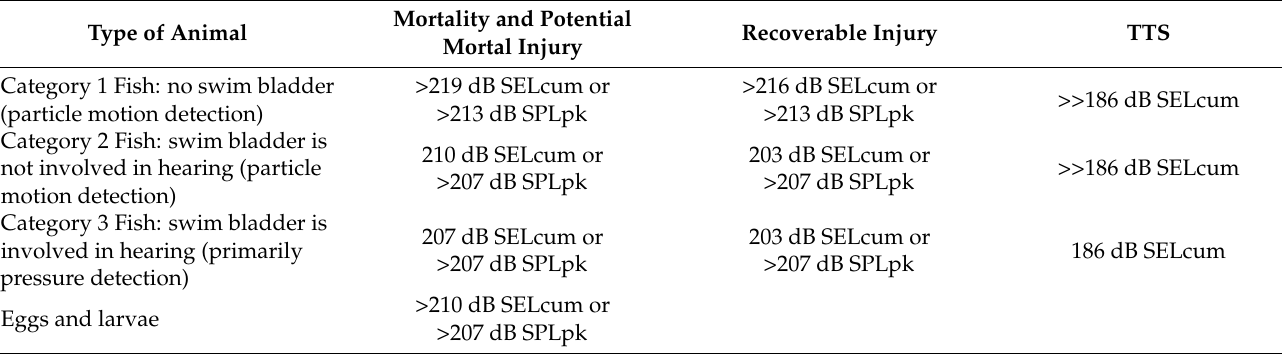
Table 4. Mortality and potential mortal injury, recoverable injury and Temporary Threshold Shift (TTS) for fish and